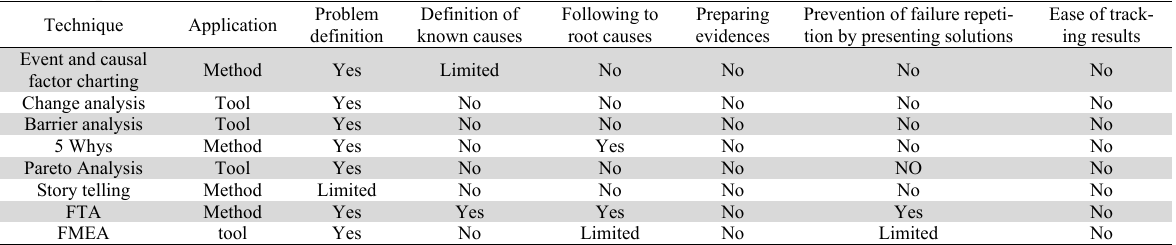
The comparison of RCFA tools (Gano,